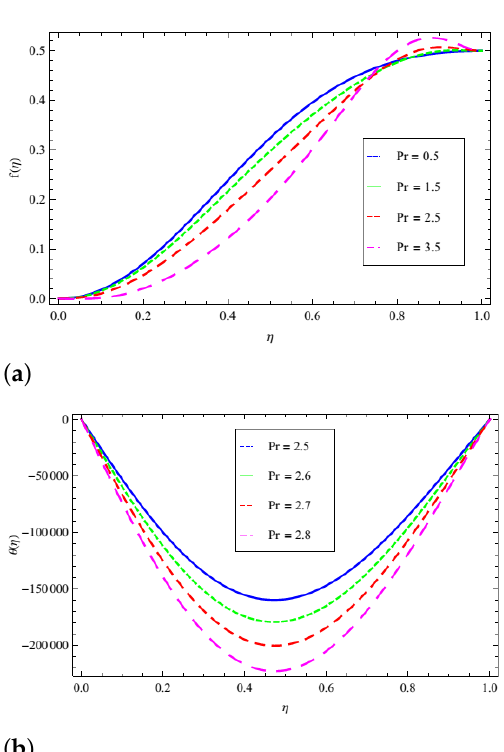
Figure 6. Impact of P r on ( a ) velocity component along x-axis f ( η ) and ( b ) heat distribution variable θ ( η ) for specific values S = − 10, Ha = 1, δ = Sc = K 1 = K 2 = 0.5, L = 0.01, Q = 10.